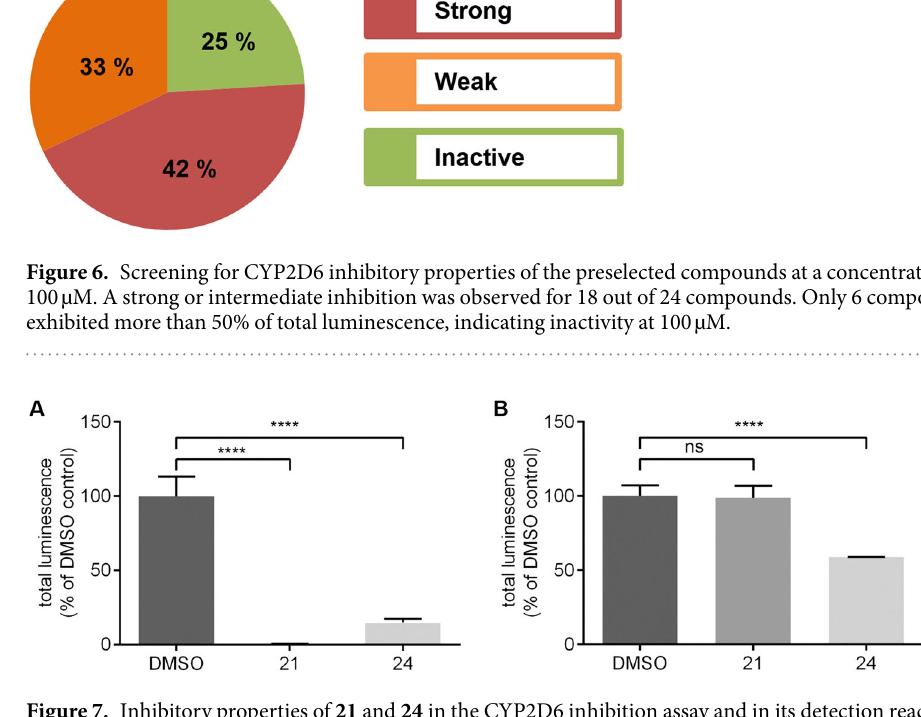
Figure 7. Inhibitory properties of 21 and 24 in the CYP2D6 inhibition assay and in its detection reaction. ( A ) Data from the CYP2D6 inhibition assay. ( B ) Data from the detection reaction. Both compounds 21 and 24 showed a strong and an intermediate inhibitory potential of CYP2D6, respectively, in graph ( A ), whereby only resveratrol ( 24) inhibited the detection reaction to a considerable amount as can be seen in graph ( B ). As the detection reaction is part of the P450-Glo CYP2D6 inhibition assay, it is necessary to ensure that the compounds do not interfere with this reaction. Shown is the mean with range of triplicate measurements of two different experimental